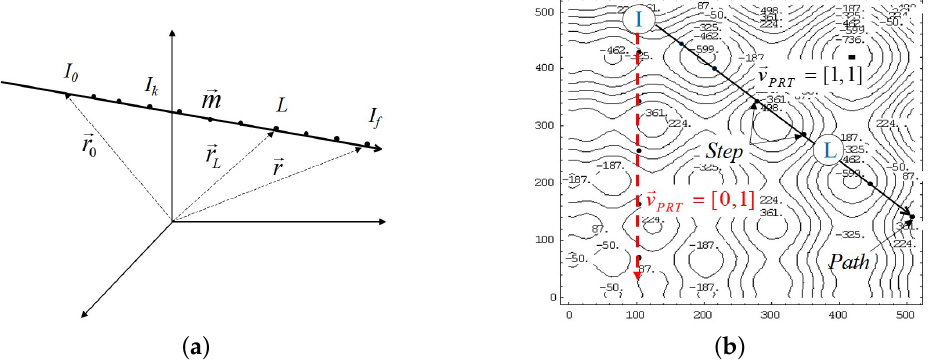
Figure 6. Migration optimization: ( a ) search path without perturbations in a 3D space; ( b ) search path with perturbation (red dashed arrow) in a 2D space. Evaluated points in individual steps are denoted by bullets •